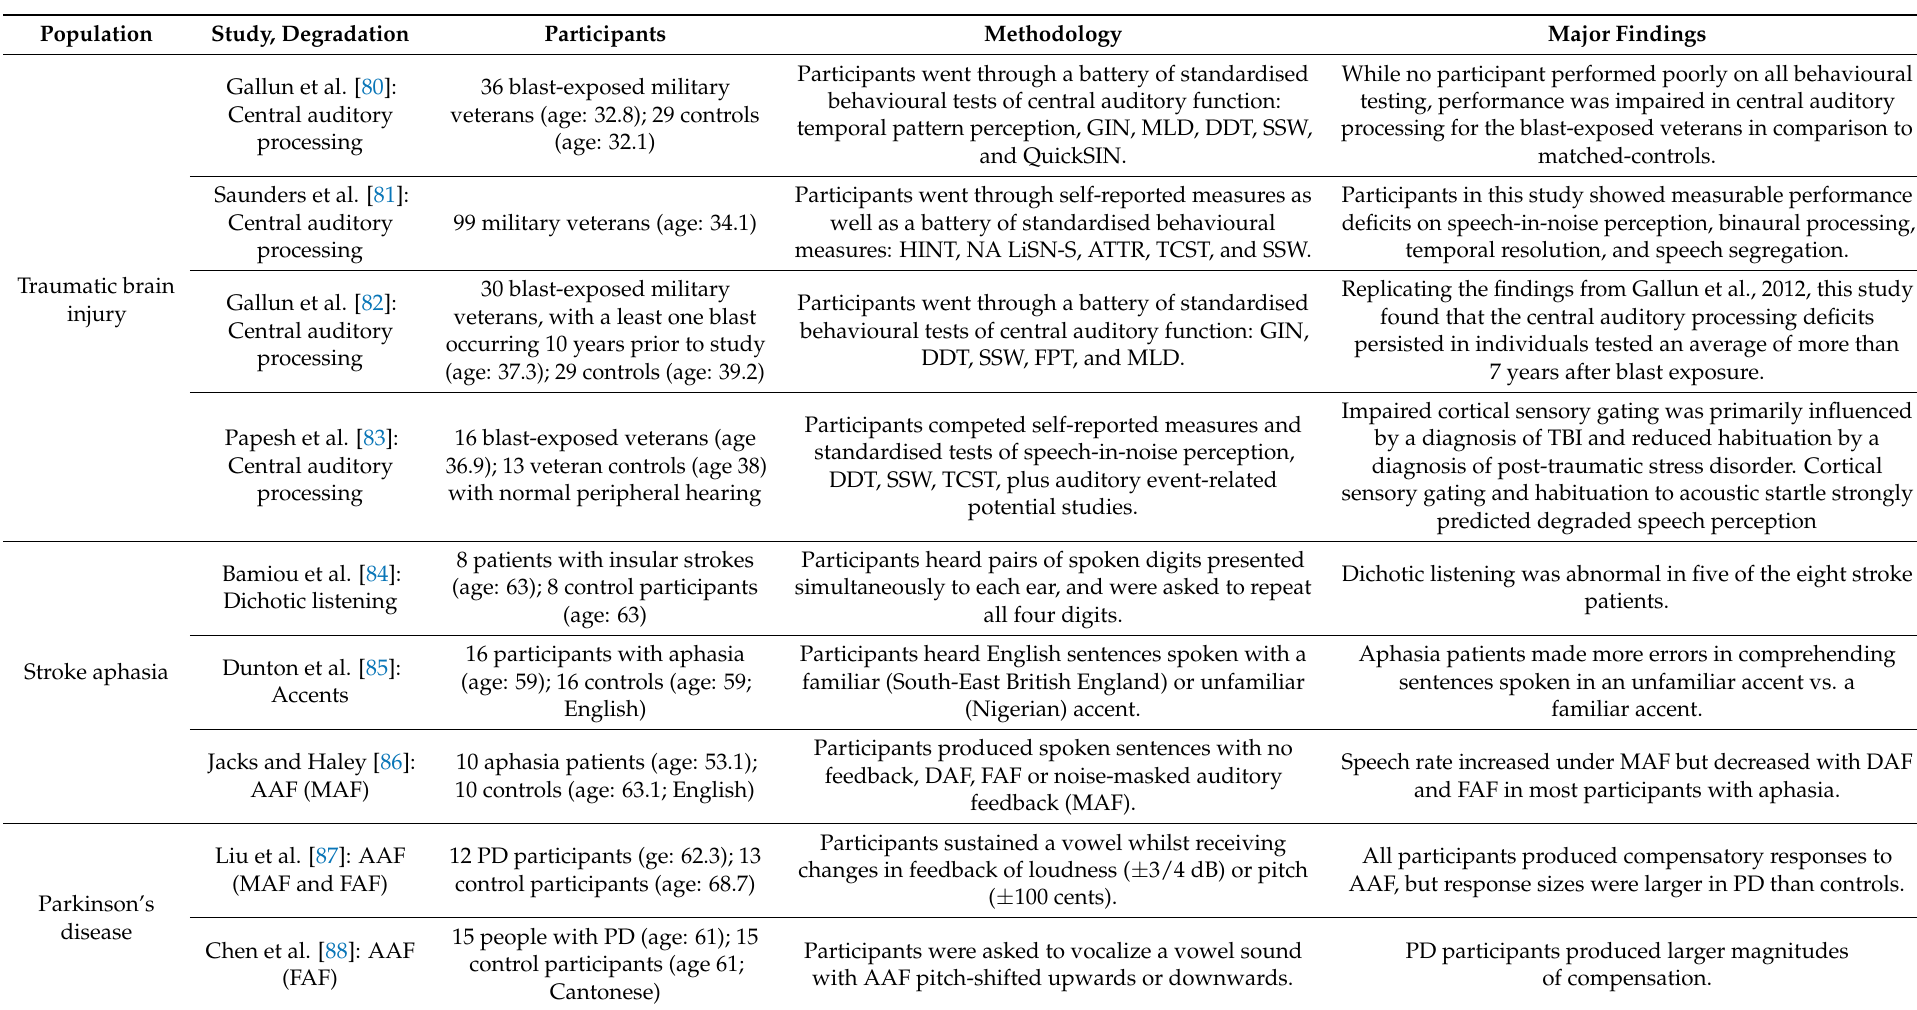
Table 2. Summary of representative studies of degraded speech processing in clinical